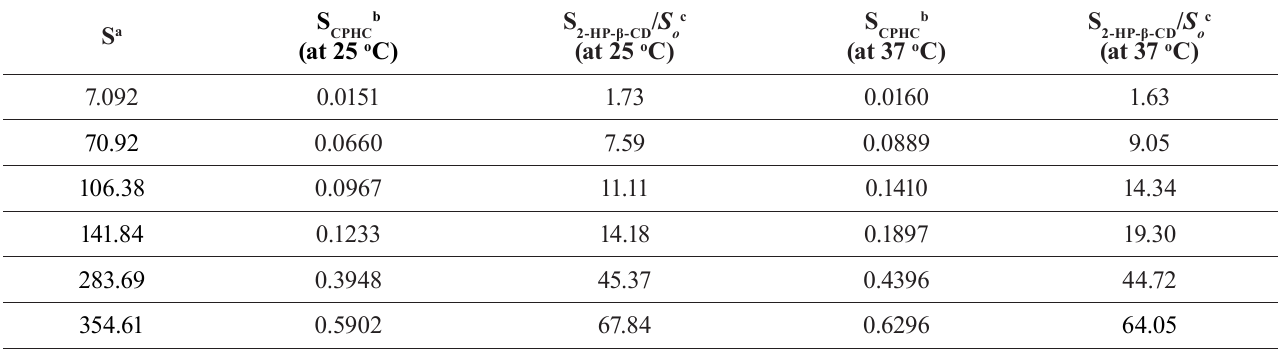
TABLE II - Solubility of CPHC in aqueous solutions depending on the concentration of 2-HP-β-CD at 25 °C and 37 ° C ± 0.1 °C